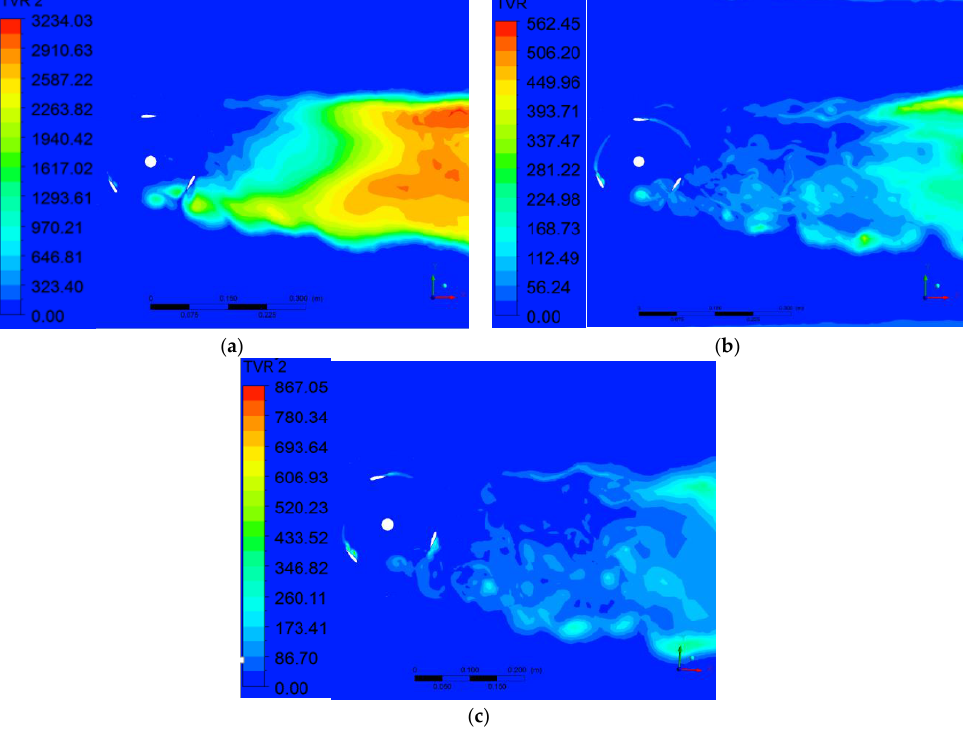
Figure 11. Instantaneous turbulent viscosity field on the symmetry plane for the ( a ) URANS, ( b ) DES and ( c ) DDES models, at λ = 2.